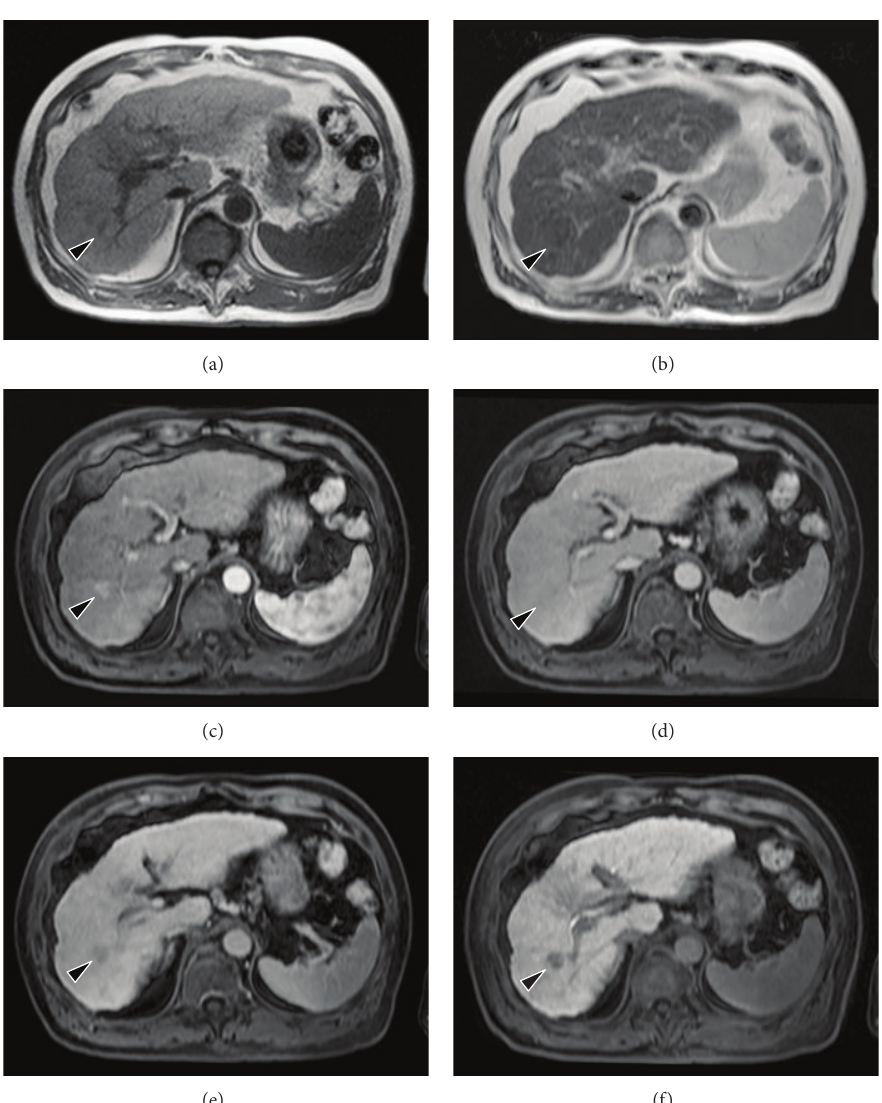
Figure 1: MR images of hepatic inflammatory pseudotumor. (a) The lesion appears isodense (arrow) on T1-weighted image. (b) A partially round, hyperintense lesion (arrow) is observed on T2-weighted image. ((c)–(f)) Gadolinium ethoxybenzyl diethylenetriamine pentaacetic acid-enhanced images. In thearterial phasefollowing contrast injection (c), thecenter of thetumoris enhanced intensely and homogeneously. In the delayed phase (d) and hepatobiliary phase (f), the tumor is completely washed out. (e) portal